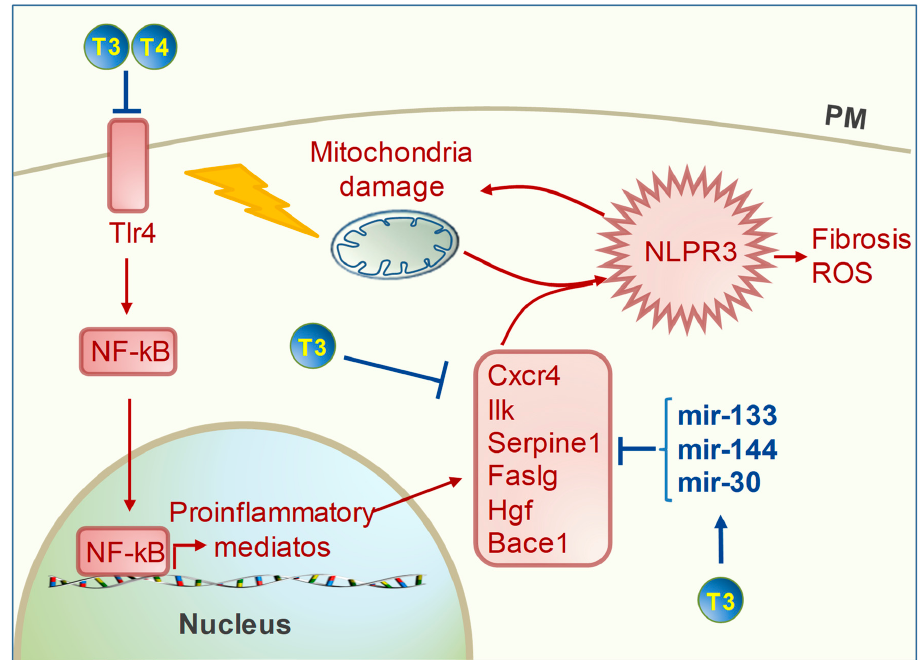
Figure 3. Anti-inflammatory effect of thyroid hormones (TH). Excessive reactive oxygen species (ROS) formation and Ca 2+ overload lead to mitochondrial dysfunction and activation of the inflammasome NLPR3, which exacerbates mitochondrial impairment and ROS production and activates the fibrotic response. TH limits the inflammasome formation by: (1) blunting the pro-inflammatory Tlr4/NF-kB axis; (2) down-regulating the expression levels of an array of pro-inflammatory mediators; (3) up-regulating the expression levels of mir-133, -144, and -30, predicted suppressors of such pro-inflammatory mediators. (Bace 1: beta secretase 1; Cxcr4: C-X-C motif chemokin receptor 4; Faslg: fas ligand; Hgf: hepatocyte growth factor; Ilk: integrin-linked kinase; NF-kB: nuclear factor kappa B; NLPR3: inflammasome; Tlr4: toll like receptor 4).